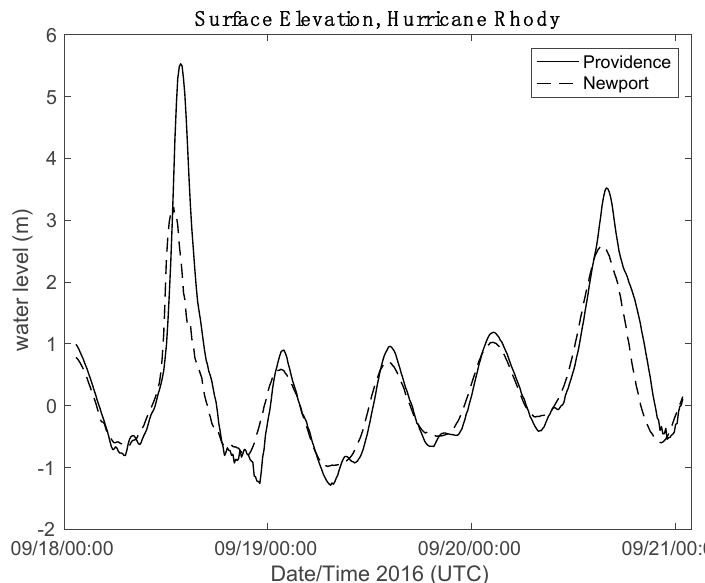
Figure 9. Time series of model water surface elevation during Hurricane Rhody at Providence and Newport. The model grid does not include the FPHB in this case, and river inflows are not simulated. The ADCIRC / SWAN simulation with Rhody category three forcing on a mesh that includes the FPHB shows that flooding in downtown Providence (north of the Barrier) is prevented by the Barrier (Figure 10).